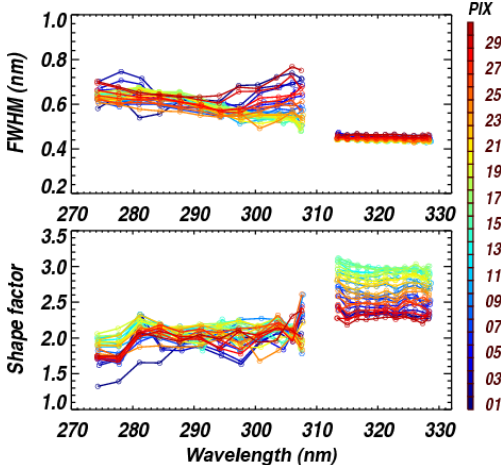
Figure 6. OMI ISRF FWHM (nm) and shape factor (k) as functions of the center wavelength, as derived from OMI solar irradiances as- suming super Gaussian functions over a range of 31 spectral pixels in 10-pixel increments. Different colors represent different cross- track positions from 1 (blue) to 30